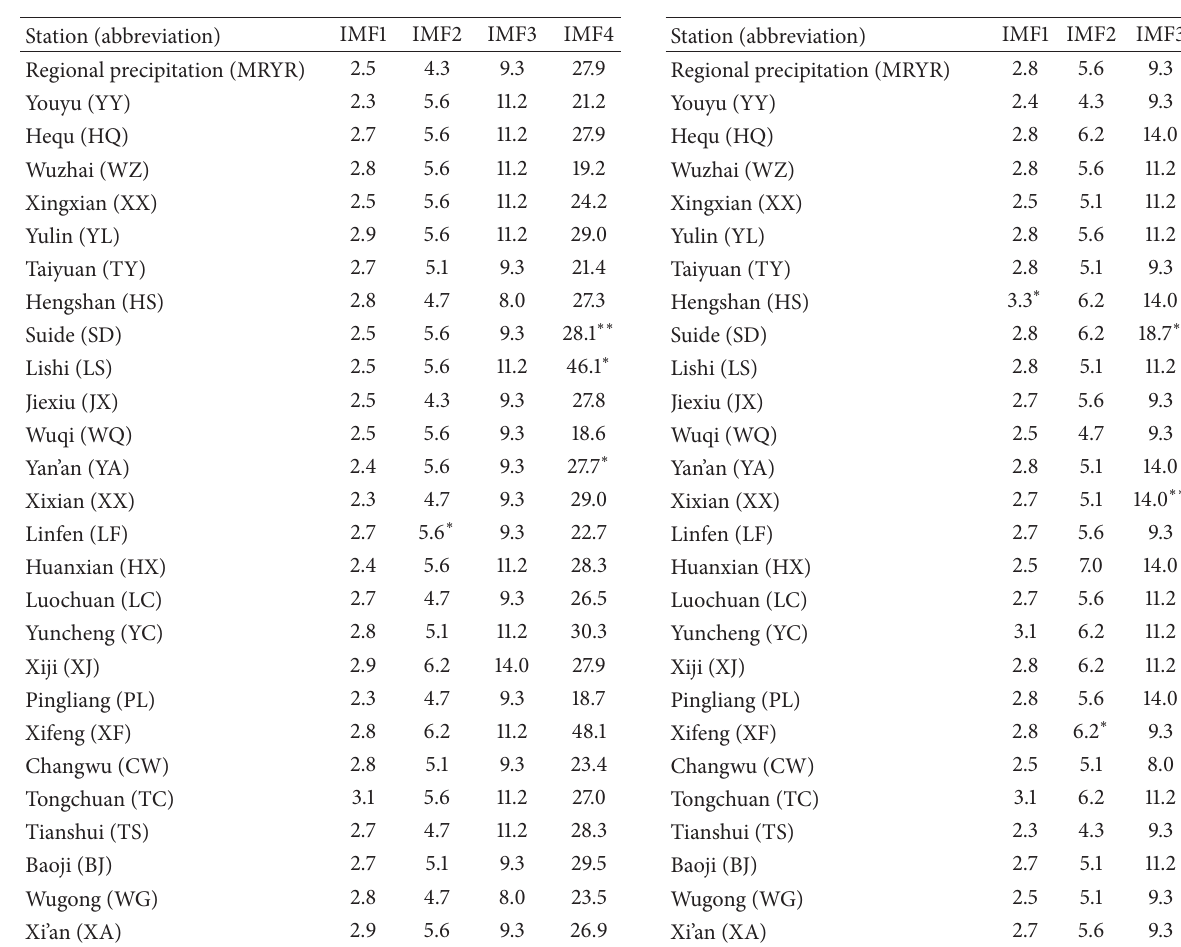
Table 3: The mean periods of various time-scale components for 𝑃 𝑓 during 1958–2013 in the MRYR obtained by the EEMD.